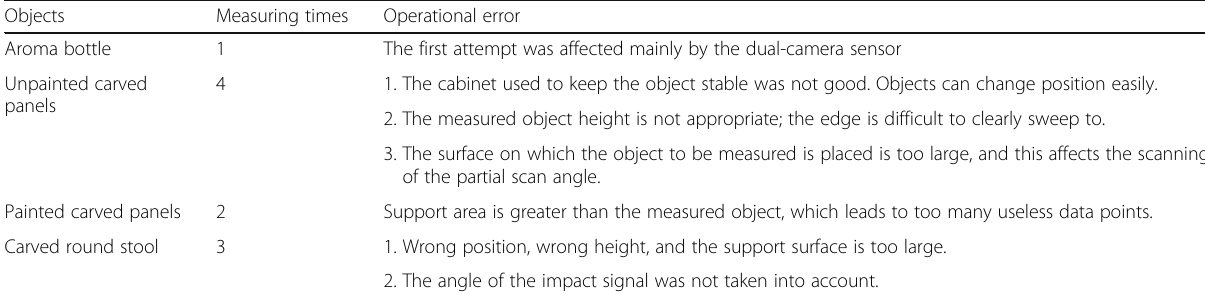
Table 3 Comparison of experimental failure causes Objects Measuring